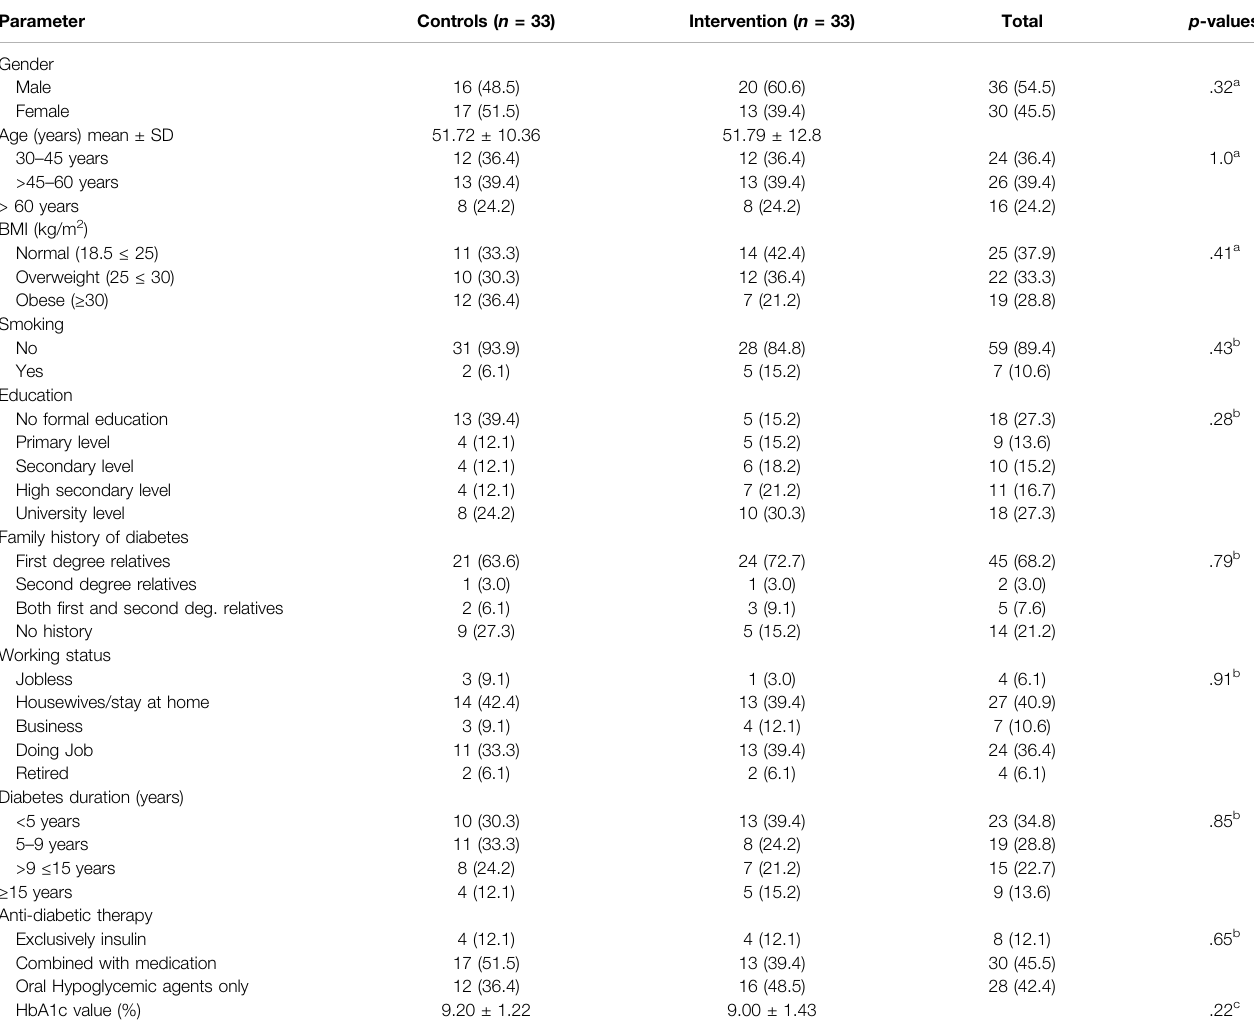
TABLE 1 | Demographics of patients in the control and intervention groups ( N = 66).